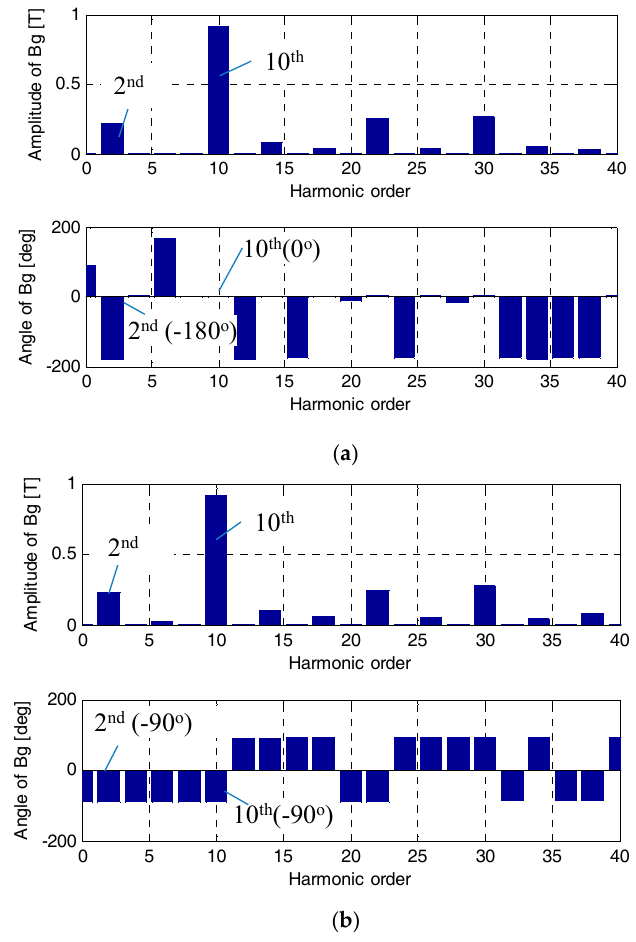
Figure 6. Magnitudes and phase angles of the harmonics of air gap flux density with rotor positons. ( a ) when θ m = 0°; ( b ) when θ m = 9°.